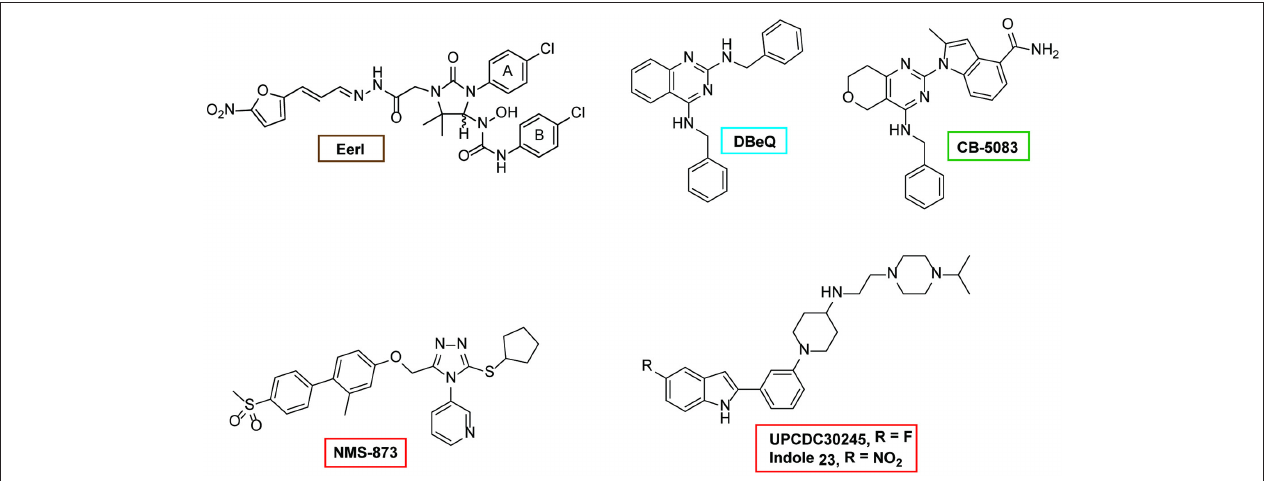
FIGURE 6 | Structures of selected p97 inhibitors. Shown are the chemical structure of some well characterized p97 inhibitors. EerI inhibits p97 function by binding to its D1 domain. DBeQ was the first reversible inhibitor that blocks the D2 ATPase activity. CB-5083 is a derivative of DBeQ, but it is much more potent than DBeQ. CB-5083 and NMS-873 are the most potent and specific p97 inhibitor identified to date. UPCDC30245 is a recently identified inhibitor and its binding to p97 has been characterized by